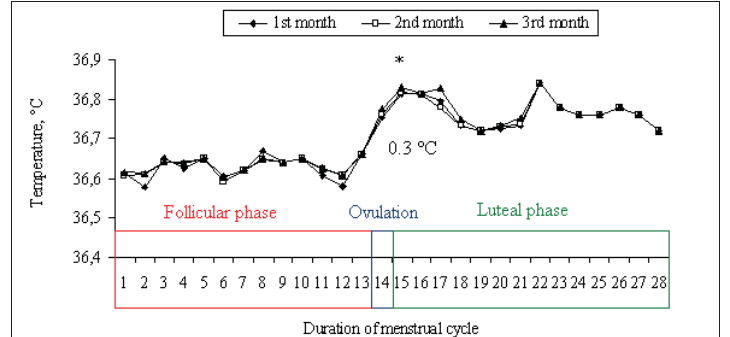
Note. * — a signi fi cant difference compare with the beginning (p <